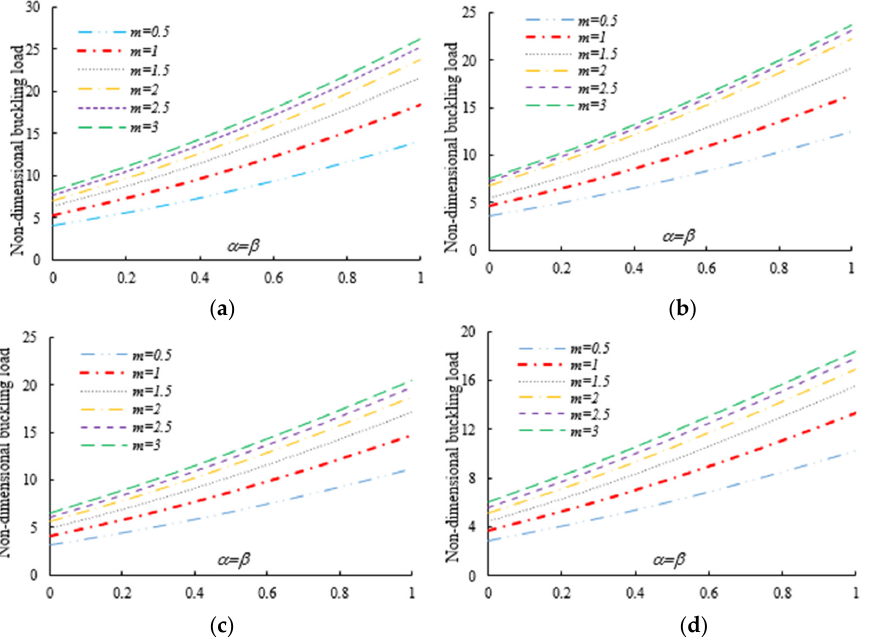
Figure 9. Variation in the flexural–torsional buckling load of I-tapered nanobeams with the tapering ratio and power-law exponent, for different nonlocality parameters (axial load on the centroid): ( a ) µ = 0; ( b ) µ = 1; ( c ) µ = 2; ( d ) µ =